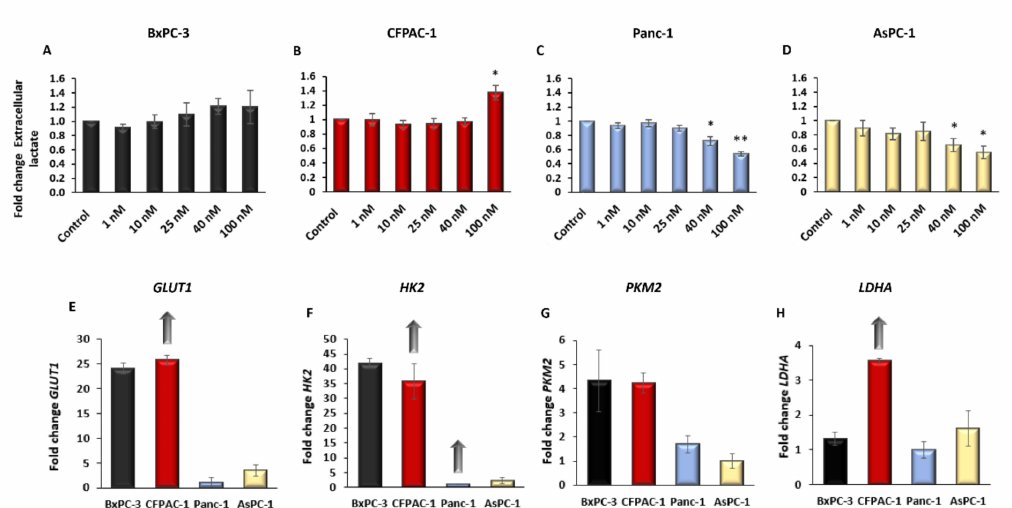
Figure 2. Extracellular lactate as a measure of aerobic glycolysis in PDAC cells after 48 h of digitoxin treatment and the basal expression of genes involved in glycolysis. Extracellular lactate produced by glycolysis measured in the media after 48 h of treatment with digitoxin, normalized to the untreated cells (control) in ( A ) BxPC-3, ( B ) CFPAC-1, ( C ) Panc-1, and ( D ) AsPC-1. The relative basal transcriptional expression (control) of ( E ) GLUT1 , ( F ) HK2 , ( G ) PKM2 , and ( H ) LDHA . A regression analysis was done for the transcriptional expression after digitoxin treatment, a significant increase in gene expression with digitoxin treatment is denoted with an arrow. The relative basal transcriptional expression level (delta Ct value, reference gene PMM1 ) is shown as fold change compared with the cell line with the lowest expression. Arrow denotes a significantly increased expression with digitoxin treatment. Error bars = SEM, Student’s t -test * p ≤ 0.05, ** p <